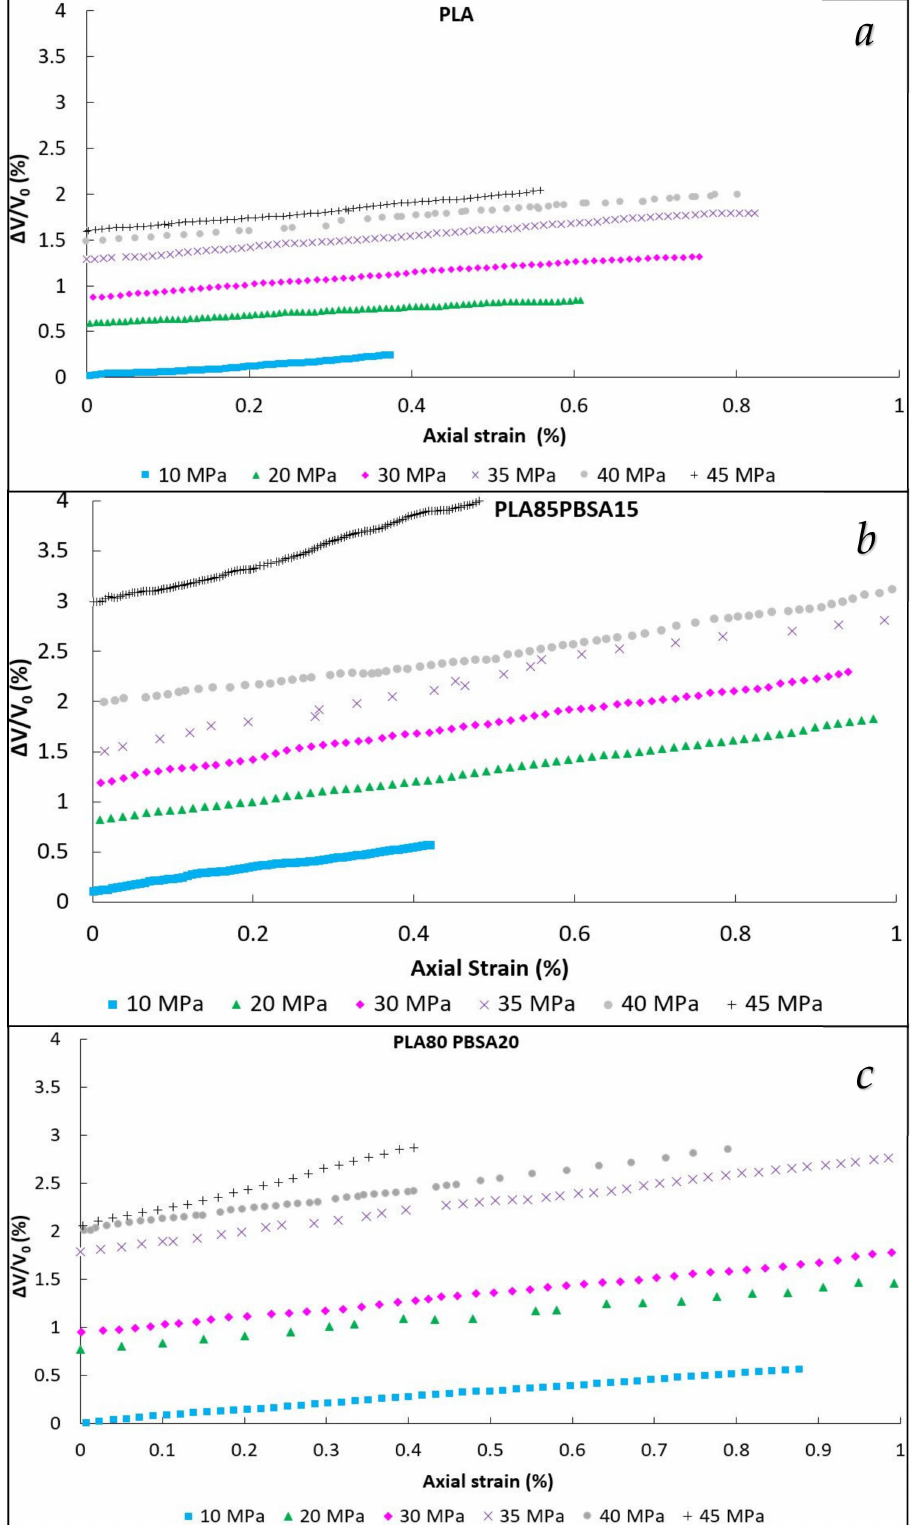
Figure 3. Volume variation vs. axial strain curves (dilatometric curves) of pure PLA ( a ), 85-15 ( b ), and 80-20 ( c